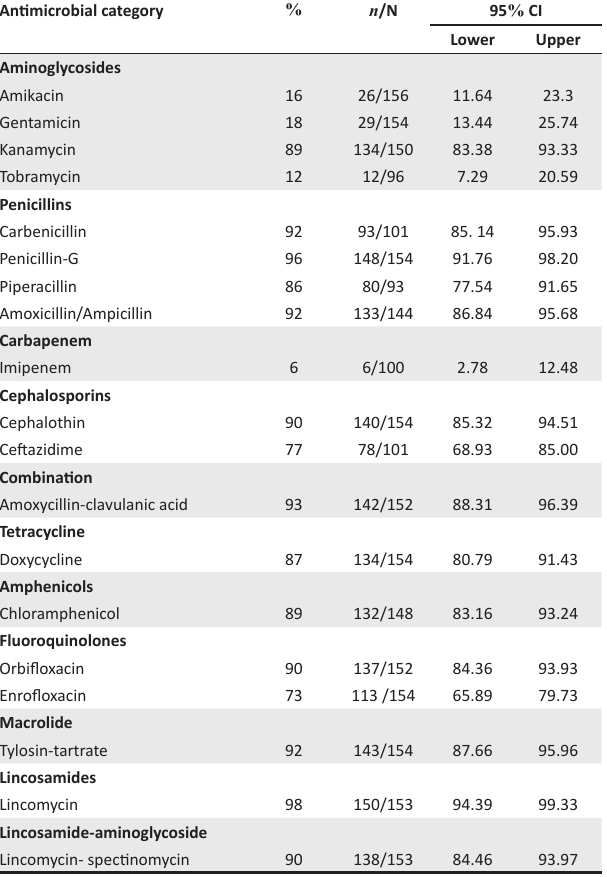
TABLE 1: Antimicrobial resistance profile of Pseudomonas aeruginosa isolates from dog clinical samples tested at a veterinary academic hospital, South Africa. Antimicrobial category